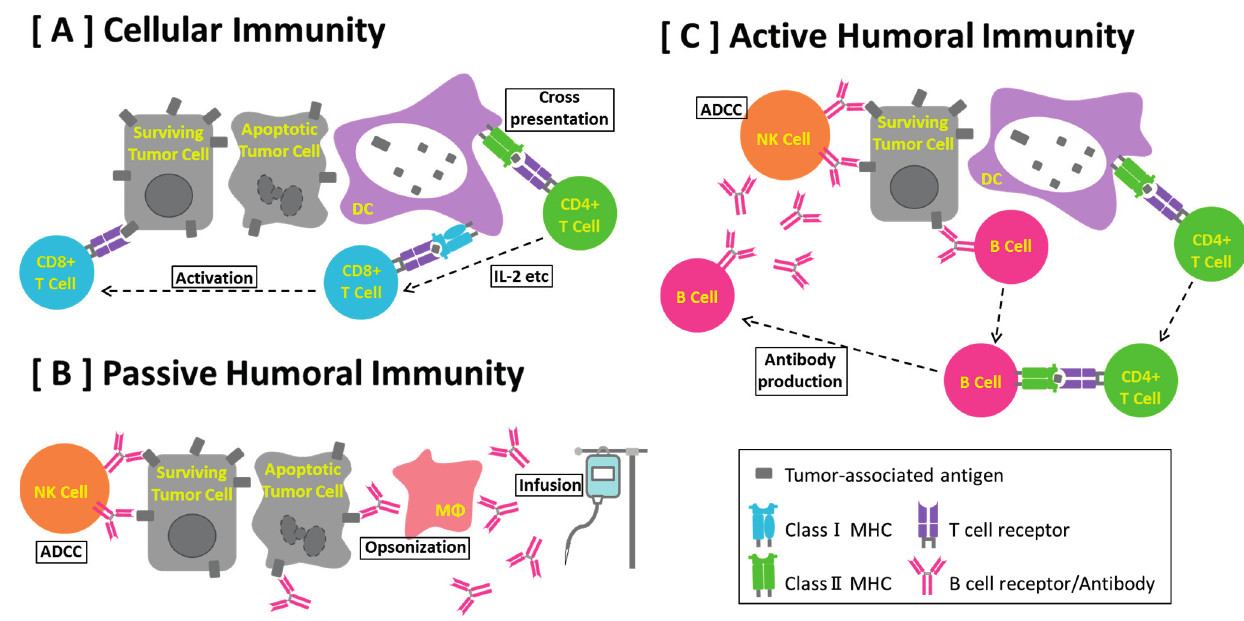
Figure 1. Anti-cancer pathways. ( A ) Apoptotic tumor cells are digested by dendritic cells (DCs). The tumor antigens are presented by class II MHCs and activate tumor-specific helper T (Th) cells. Tumor-associated antigens are also cross-presented by class I MHCs. Class I MHC-presented antigens activate cytotoxic T (Tc) cells, and Th cells support this activation. As a result, Tc cells can attack tumor cells. ( B ) Passively induced monoclonal anti-tumor antibodies recognize tumors which express high level of tumor-associated antigens on their surface, leading to opsonization. The opsonized tumor cells are injured by NK cells and neutrophils through antibody-depended cell cytotoxicity (ADCC). ( C ) A peptide vaccine with highly limited epitopes induces Th activation. Following peptide antigen presentation by class II MHCs on DCs, Th cells are activated and signal B cells to secrete peptide-specific antibodies. The antibodies may induce ADCC similarly to passive humoral